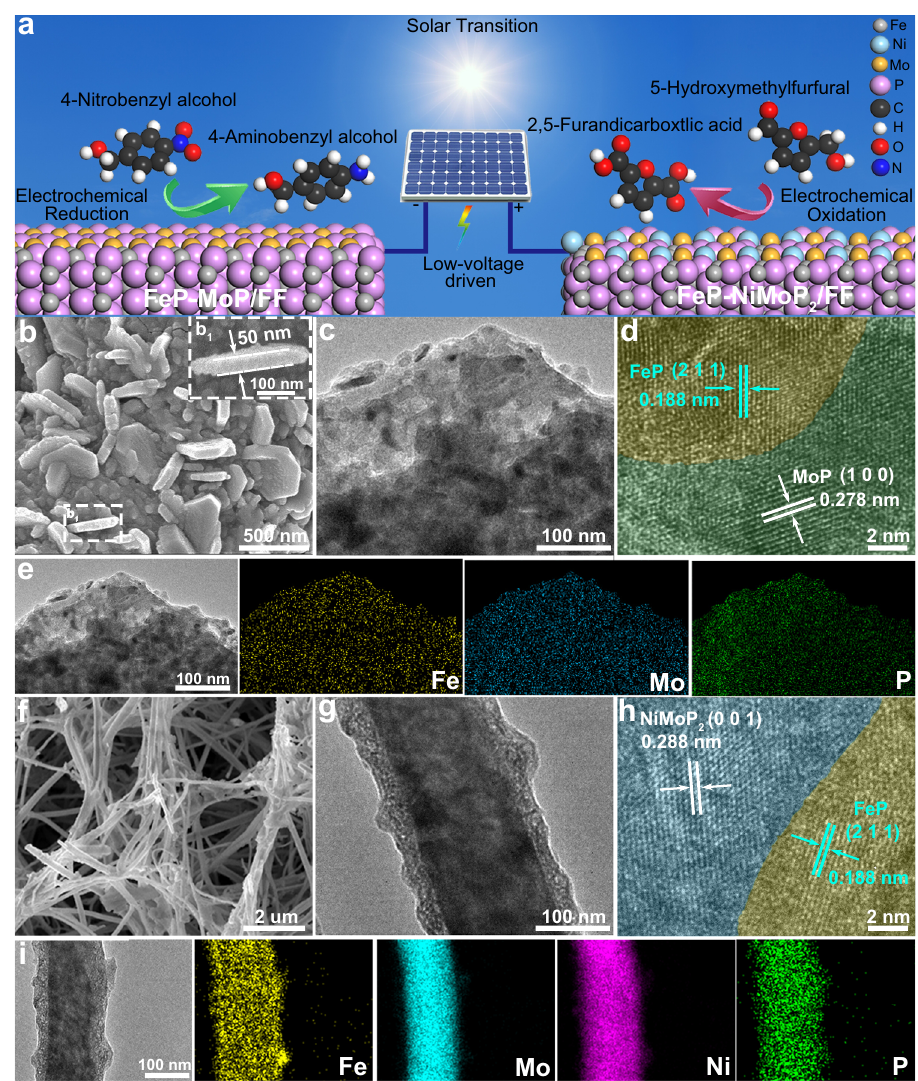
Fig. 1 Morphology characterization of FeP-MoP/FF and FeP-NiMoP 2 /FNF. a Illustration for the paired 4-NBA ERR and 5-HMF EOR system driven by solar-cell. b SEM image (inset: the cross section SEM image), c TEM image, d HRTEM image. e STEM image and EDX mappings of Fe, Mo, and P of FeP- MoP/FF. f SEM image, g TEM image, h HRTEM image, i STEM image and EDX mappings of Fe, Mo, Ni, and P of FeP-NiMoP 2